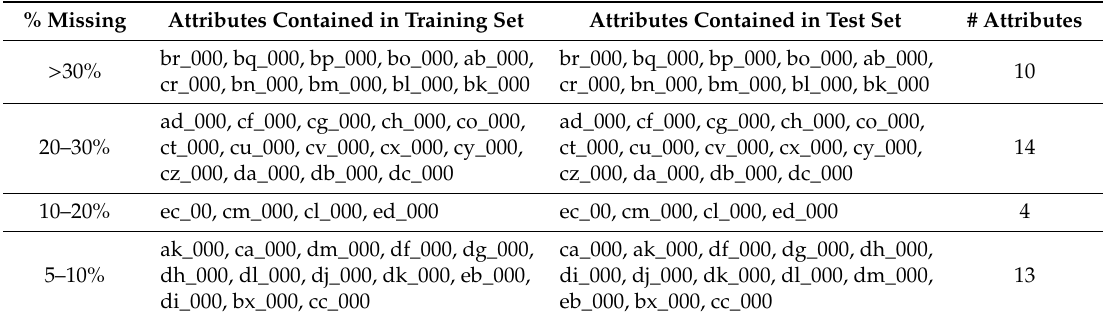
Table 4. Contained attributes by sorted missing percentages.